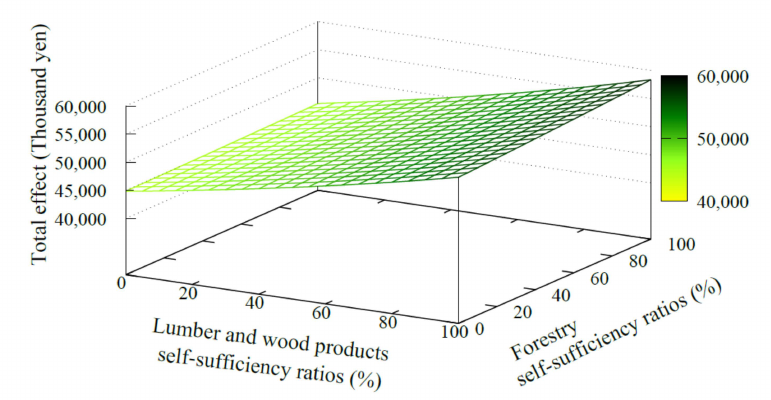
Figure 4. Impact of changes in the prefecture’s self-su ffi ciency ratios for the lumber and wood products and forestry sectors on the total e ff ect.